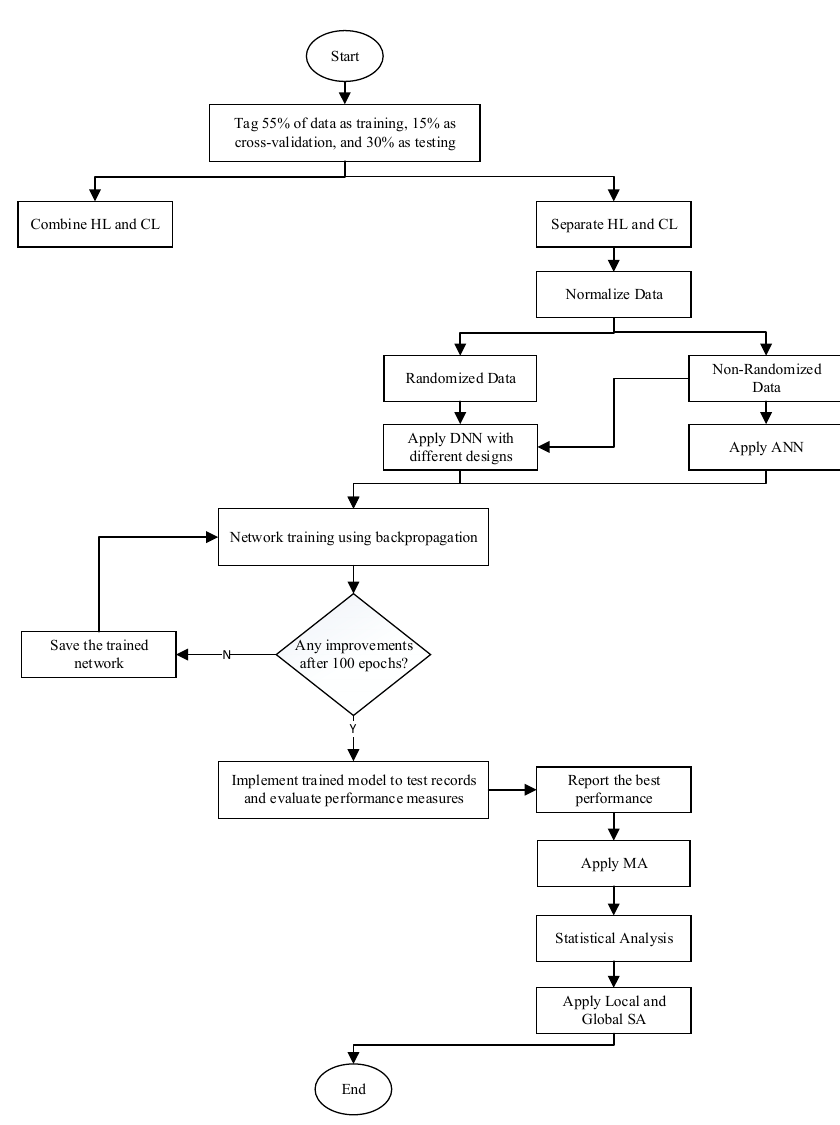
Figure 2. Methodology Framework.